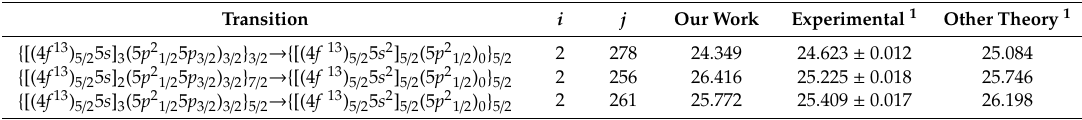
Table 2. Comparison of calculated wavelengths (in nm) using FAC with other wavelengths for various transitions in Eu-like W. i and j represent the sequential numbers assigned in Table 1 to the lower and upper levels,